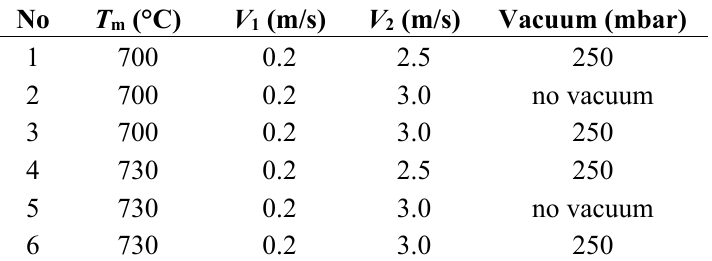
Table 2. Experimental conditions of vacuum cold chamber die-casting.